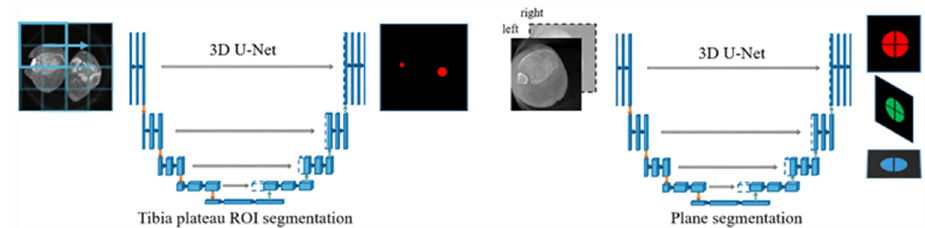
Figure 4. Explanation of U-Net, a CNN used to compare bilateral ankles during fracture reduction. Image patches from a single CT scan of the bilateral ankles are inserted into the network and fused to predict a region of interest (ROI) containing the tibial plateau. Based on this ROI extracted, a second U-Net predicts three binary images that represent the planes of the ROI. Reprinted with permission from [37]. Copyright 2021 Springer Link.